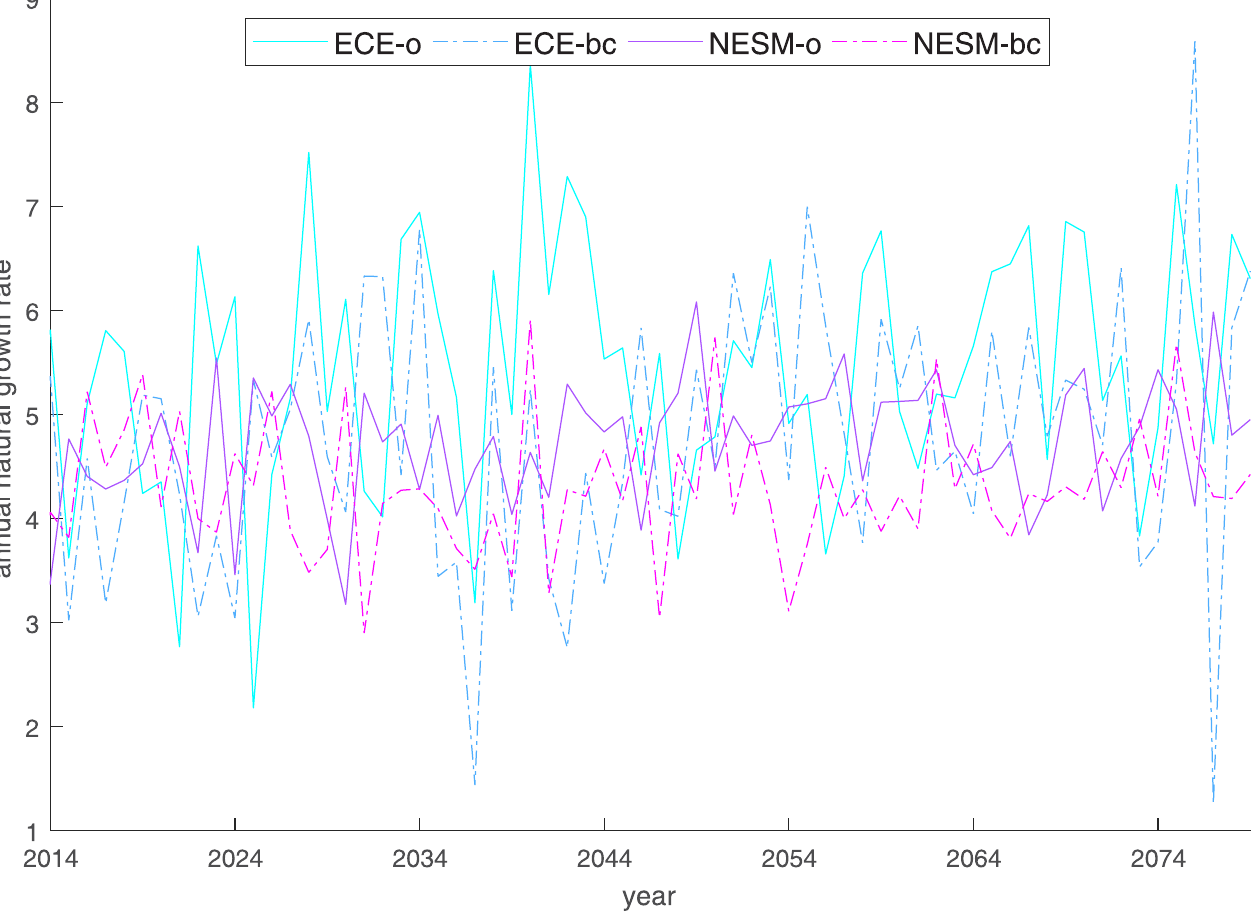
) for different climate projections. y